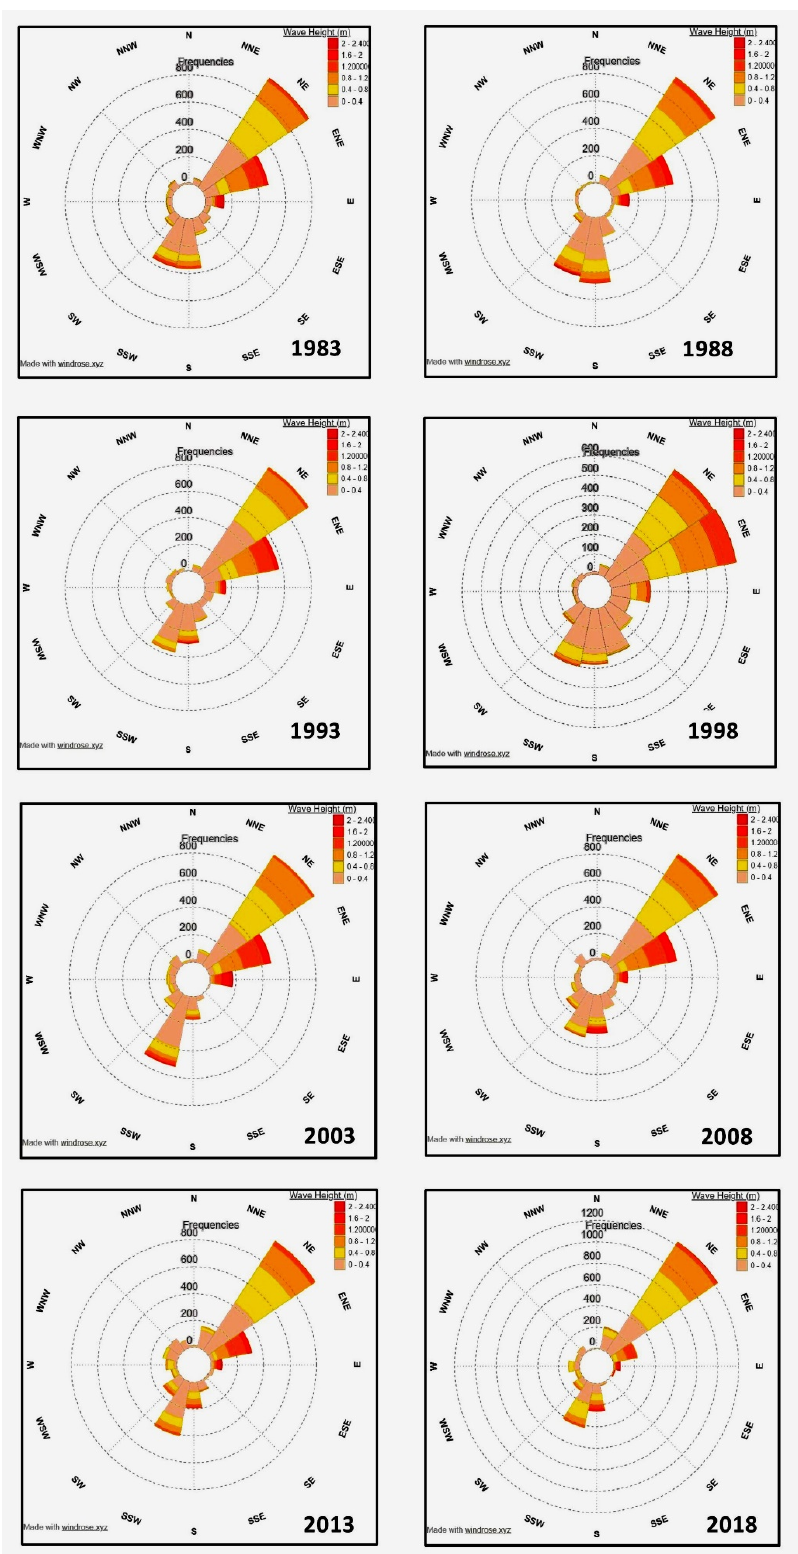
Figure 8. Wave rose diagram at station 10 (11.0° N Lat., 121.0° E Long.) having a 5-year interval (data source: MOV).